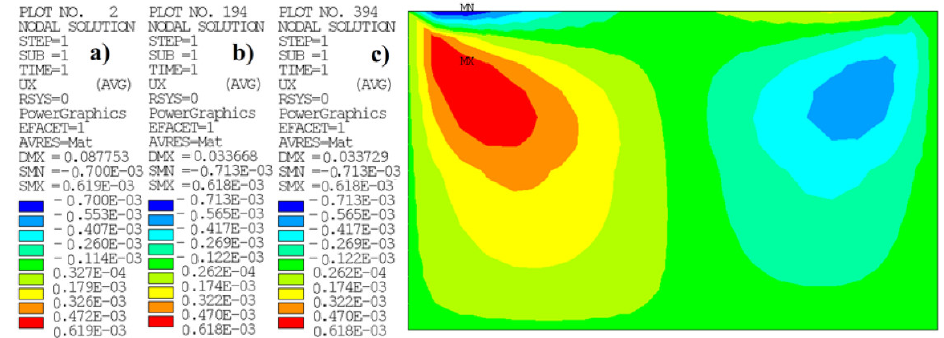
Figure 3. U x displacement below the foundation at ( a ) 13.93, ( b ) 682.57, and ( c ) 1379.07 days.